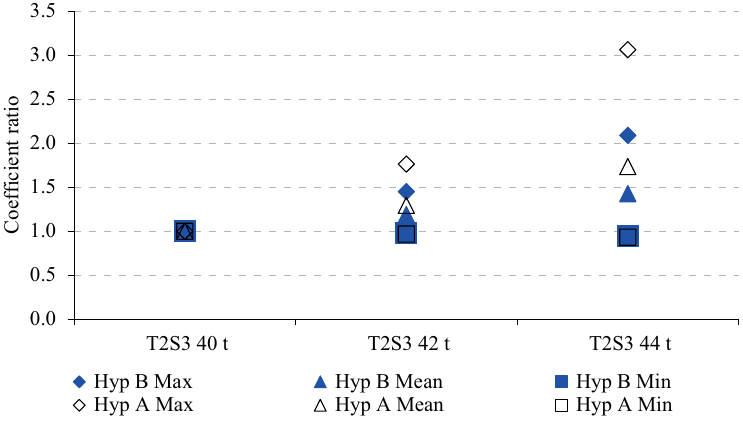
Figure 7. Maximum, minimum and mean values of the coefficient